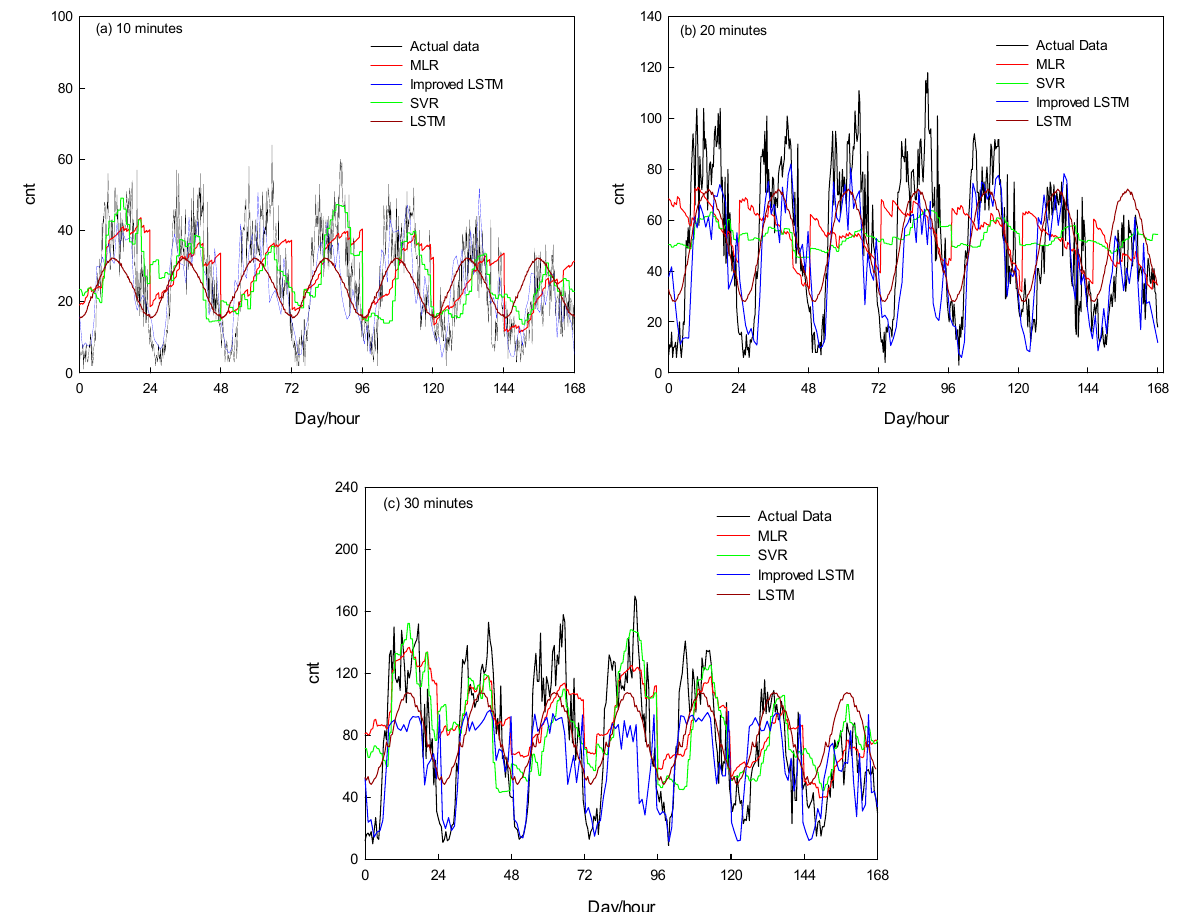
Figure 10. Evaluation results of PL5 using four models for 10 min, 20 min, and 30 min.